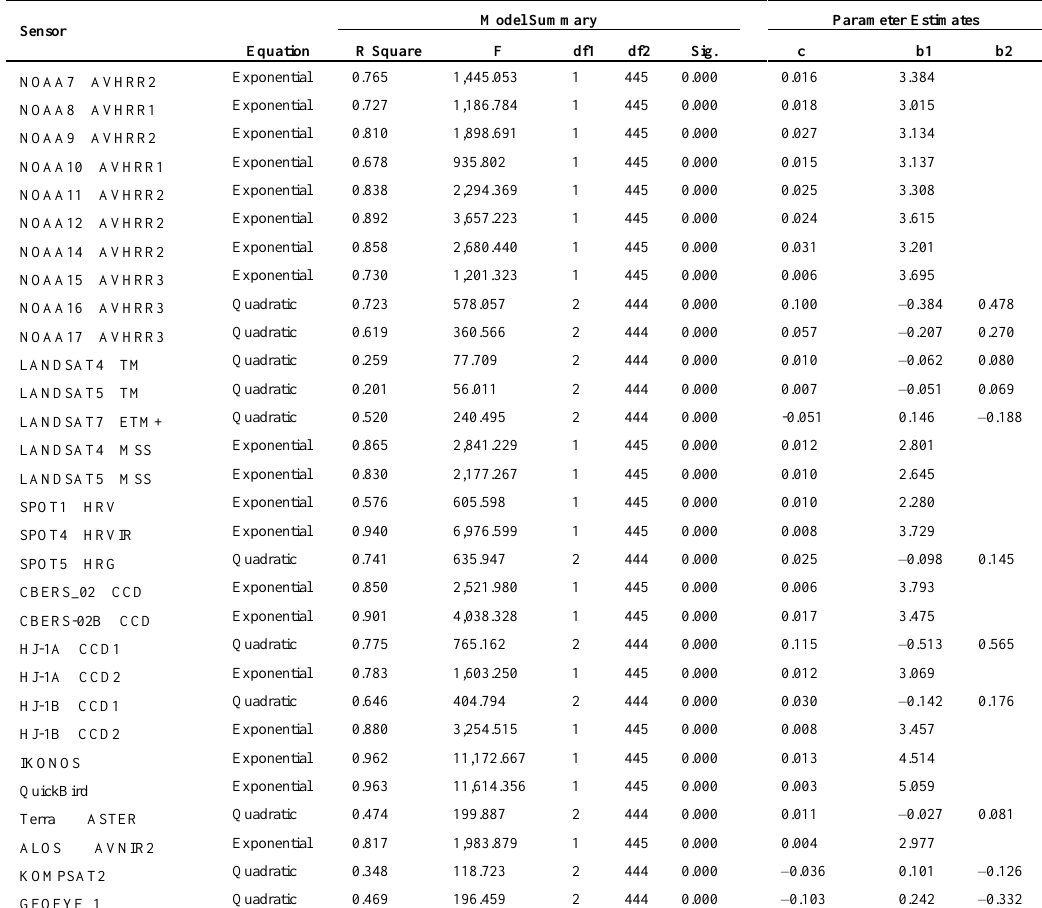
Table 3. Parameters of the exponential and quadratic fit to the relative spectral correction for simulated reflectance in the red channel. Quadratic equation: y = c + b1 x + b2 x 2 ; Exponential equation: y = c·exp(b1 x ), y denotes RPD in the red reflectance, x denotes NDVI for particular